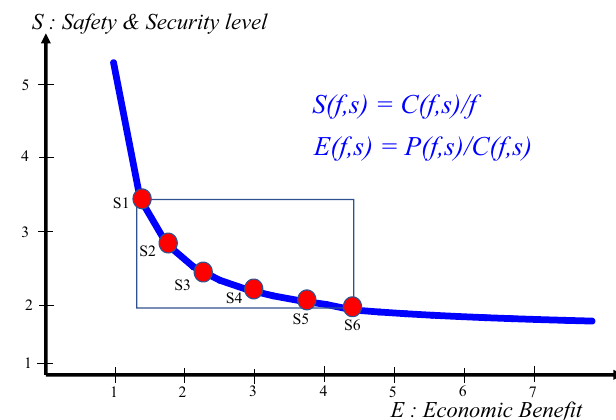
Figure 3. Balance of safety and security with economic